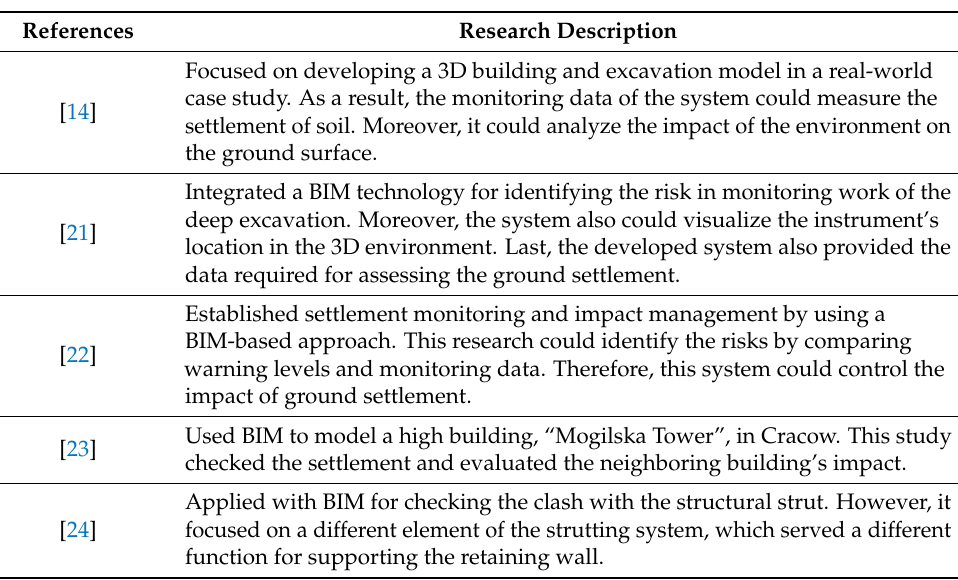
Table 2. Studies between the deep excavation and